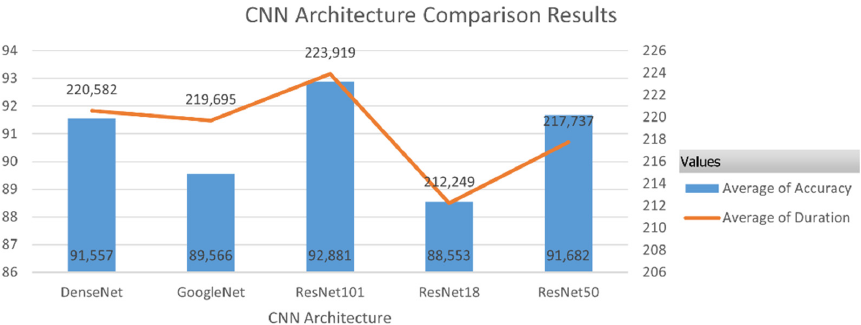
Figure 14. CNN Architecture Comparison Results.